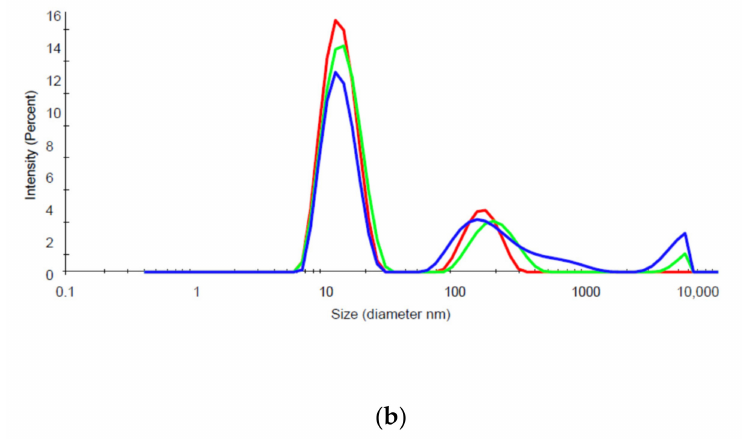
Figure 6. DLS traces of mAb14 ( a ), mAb17 ( b ). Different colors depict three different measurements. Larger aggregates are seen for mAb14 as indicated by the size corresponding to the major peak. The major peak from mAb17 solution appears at a position typical for IgG